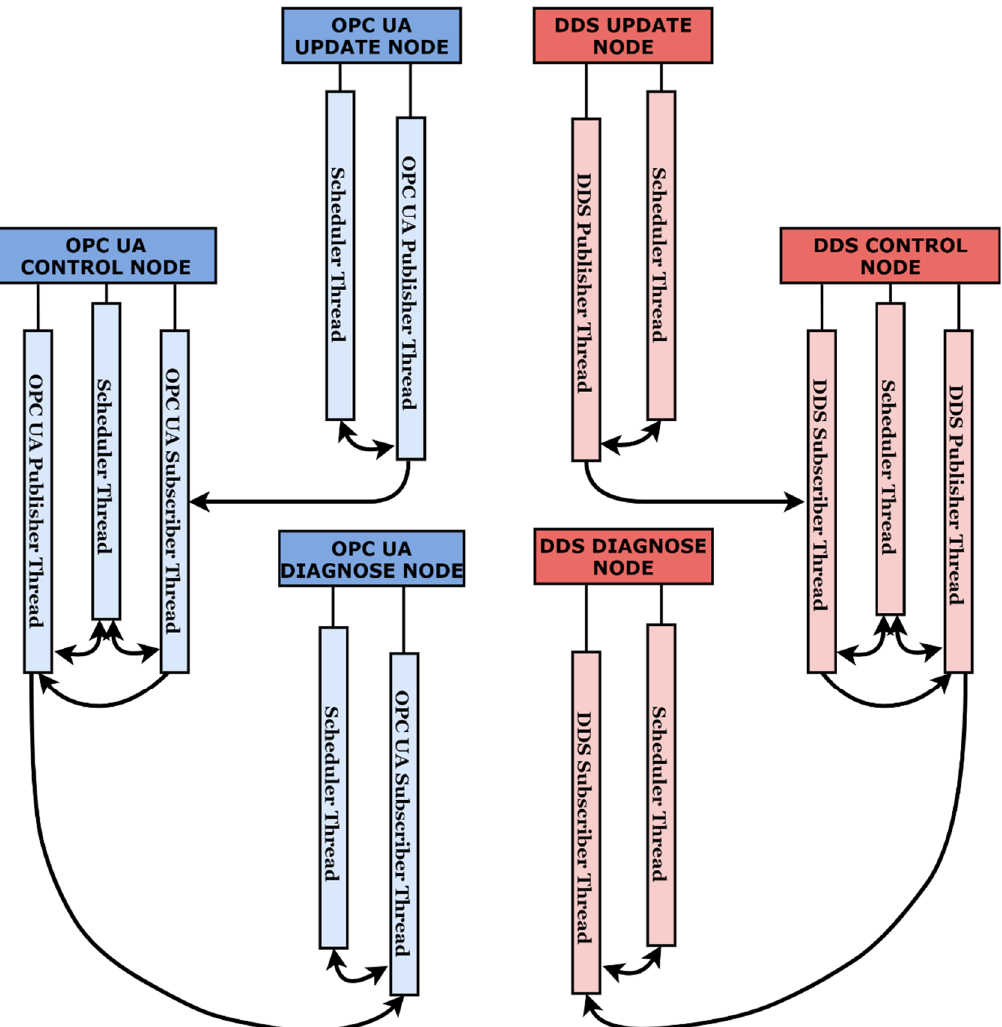
Figure 3. Multithreading nodes from an architectural perspective.